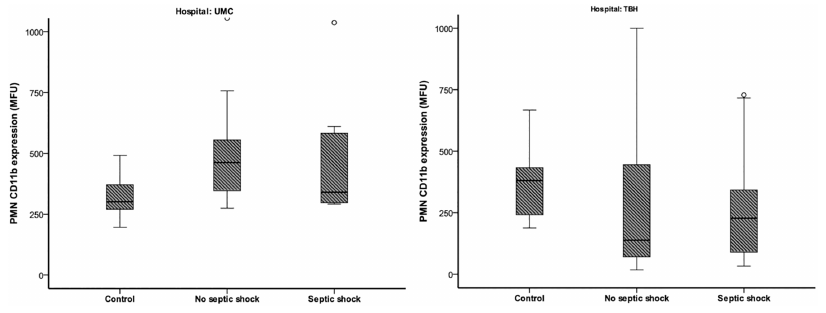
Fig 1. CD11b expression on PMNs. RelationbetweenCD11b expressionon PMNs (mean fluorescence intensities; MFI in arbitrary units; AU) and the development of inflammatory complications. Complications are depictedaccordingto the sepsis consensusconference and dividedby hospital:UniversityMedical Center Utrecht (UMC), Tyberberg HospitalStellenbosch (THB). In UMC ( A ) a significantincrease was found in all patients (p < 0.006)compared to controls. No differences were found betweenpatients. In TBH ( B ) no differences were found betweenpatients and controls, nor betweenpatients with septic shock and all other